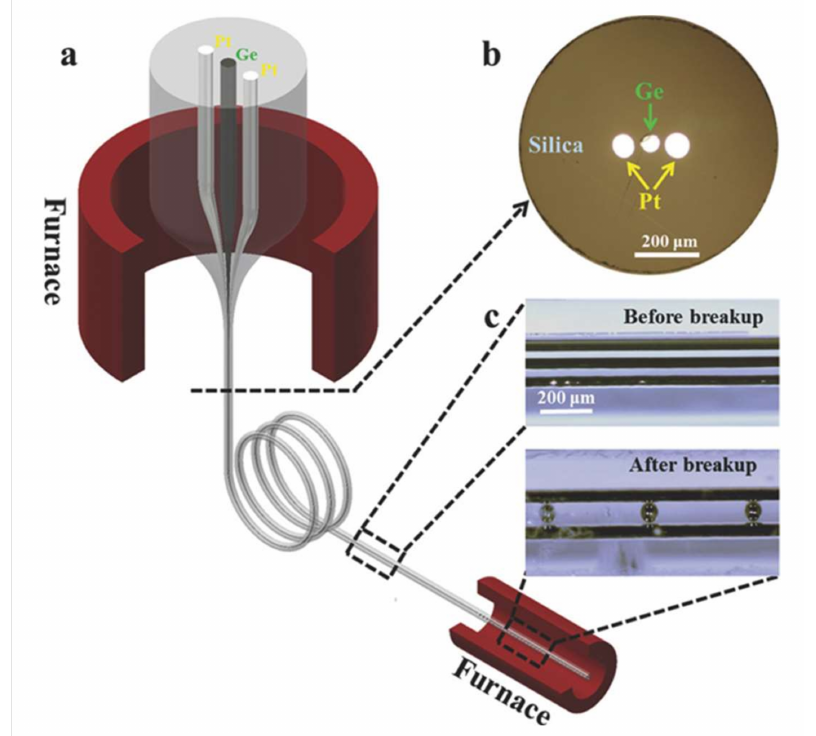
Figure 9. All-in-fiber germanium-platinum optoelectronic sensing units. ( a ) Multimaterial fiber drawn by fiber thermal drawing process. ( b ) Cross-section of germanium-platinum optoelectronic fiber. ( c ) Continuous germanium and platinum fiber cores (top, before breakup) and assembled germanium-platinum micron functional units by thermal induced in-fiber capillary instabilities (bottom, after breakup). Reprinted with permissions from ref. [106]. Copyright 2017, WILEY-VCH Verlag GmbH & Co. KGaA, Weinheim,